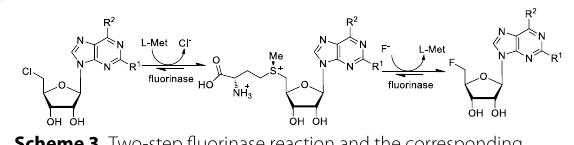
Scheme 3 Two‑step fluorinase reaction and the corresponding